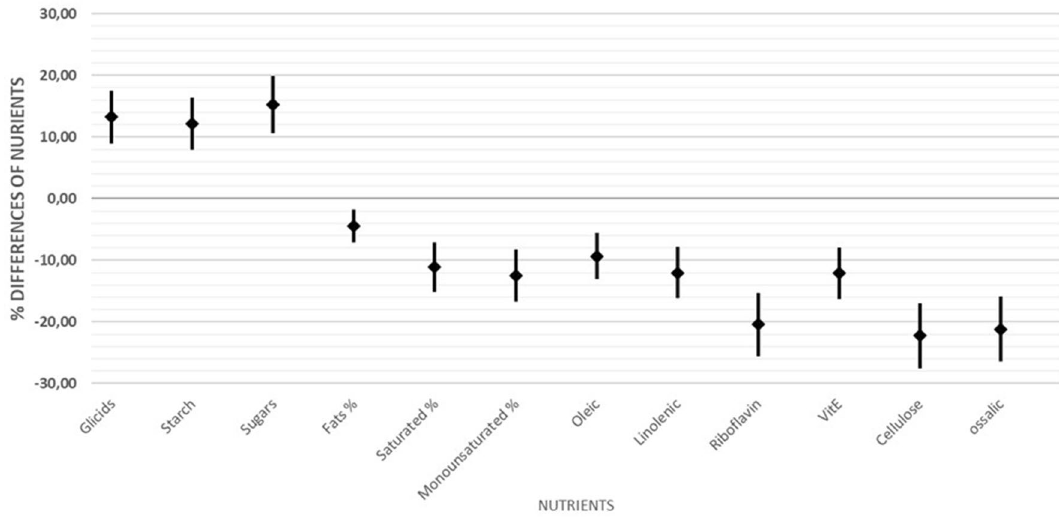
Figure 4. Differences in the mean intake (± 95% C.I.) of nutrients in the second year of life between celiac disease (CD) cases and controls